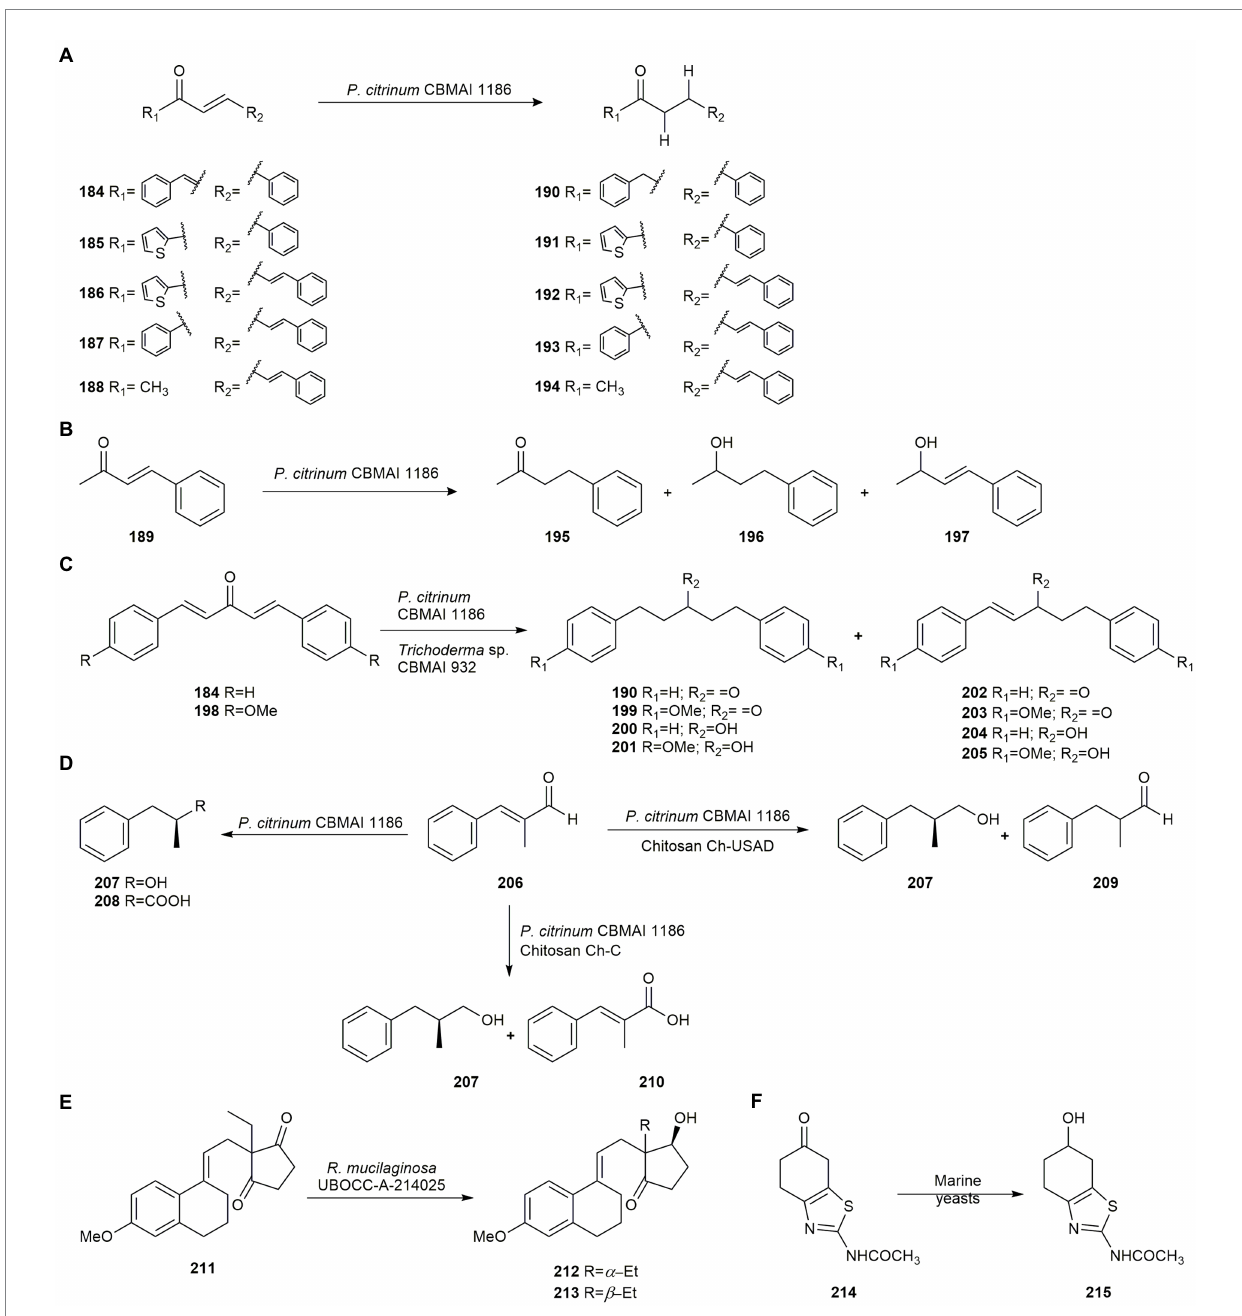
FIGURE 9 Biotransformations of carbonyl compounds. (A) Hydrogenation of the α , β - unsaturated ketones 184–188 by Penicillium citrinum CBMAI 1186 (Ferreira et al., 2015b). (B) Reduction of the α , β - unsaturated ketone 189 by P. citrinum CBMAI 1186 (Ferreira et al., 2015b). (C) Hydrogenation of bis- α , β - unsaturated enones 184 and 198 by P. citrinum CBMA1186 and Trichoderma sp. CBMAI 932 (Ferreira et al., 2015a). (D) Biotransformation of ( E )-2-methyl-3- phenylacrylaldehyde ( 206 ) by P. citrinum CBMA1186 (Ferreira et al., 2020). (E) Biotransformation of ethyl secodione ( 211 ) by Rhodotorula mucilaginosa UBOCC-A-214025 (Serra et al., 2016). (F) Bioreduction of the ketone 214 by Meyrozyma guillermondii and R. mucilaginosa UBOCC-A-214025 (Serra et al.,